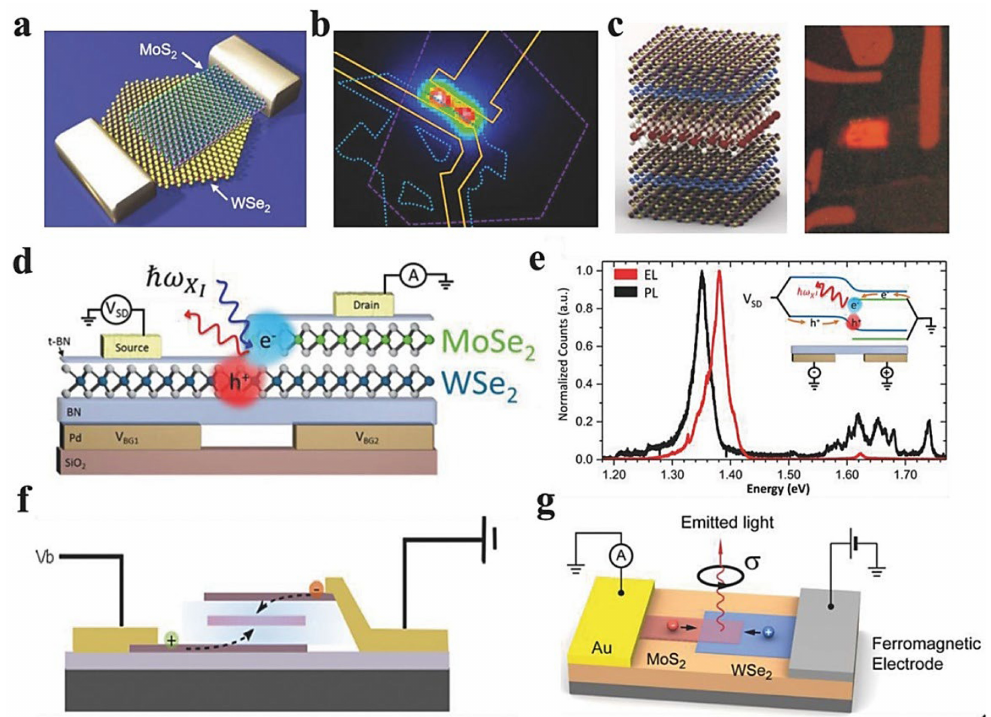
Figure 11. ( a ) Graphical illustration of heterostructure based on WSe 2 /MoS 2 . ( b ) EL spectra (false color) of device using 100 µ A injection current. Adapted with permission from Ref. [152]. Copyright 2014, American Chemical Society. ( c ) Atomistic representation of h -BN/graphene/2 h -BN/WS 2 /2 h - BN/graphene/ h -BN single-quantum wall heterostructure and optical view of EL using the alike device. Adapted with permission from Ref. [157]. Copyright 2015, Nature Publishing Group. ( d ) Rep- resentation of assembly for heterostructure. ( e ) Visualization of PL and EL spectra of heterostructure (inset: display of carrier transportation). Adapted with permission from Ref. [162]. Copyright 2017, American Chemical Society. ( f ) Demonstration of working of LED composed of a vertical heterostructure. Adapted with permission from Ref. [162]. Copyright 2016, American Chemical Society. ( g ) Schematics depiction of the proposed device. Adapted with permission from Ref. [164]. Copyright 2016, American Chemical